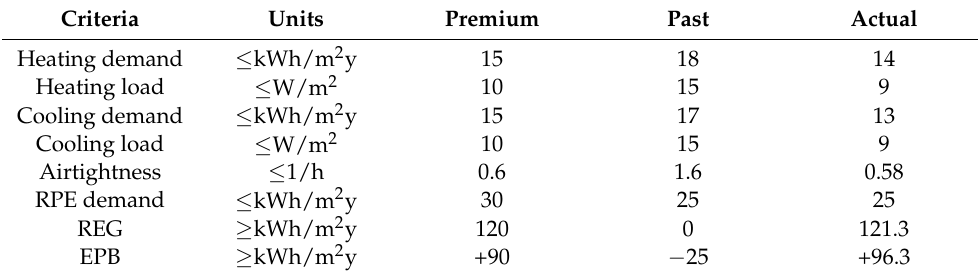
Figure 3. Location of distributed generation circuits and Active Buildings that meet the Passivhaus criteria. The solid red line represents overhead electrical wiring. Adapted from Google Maps, 2021.